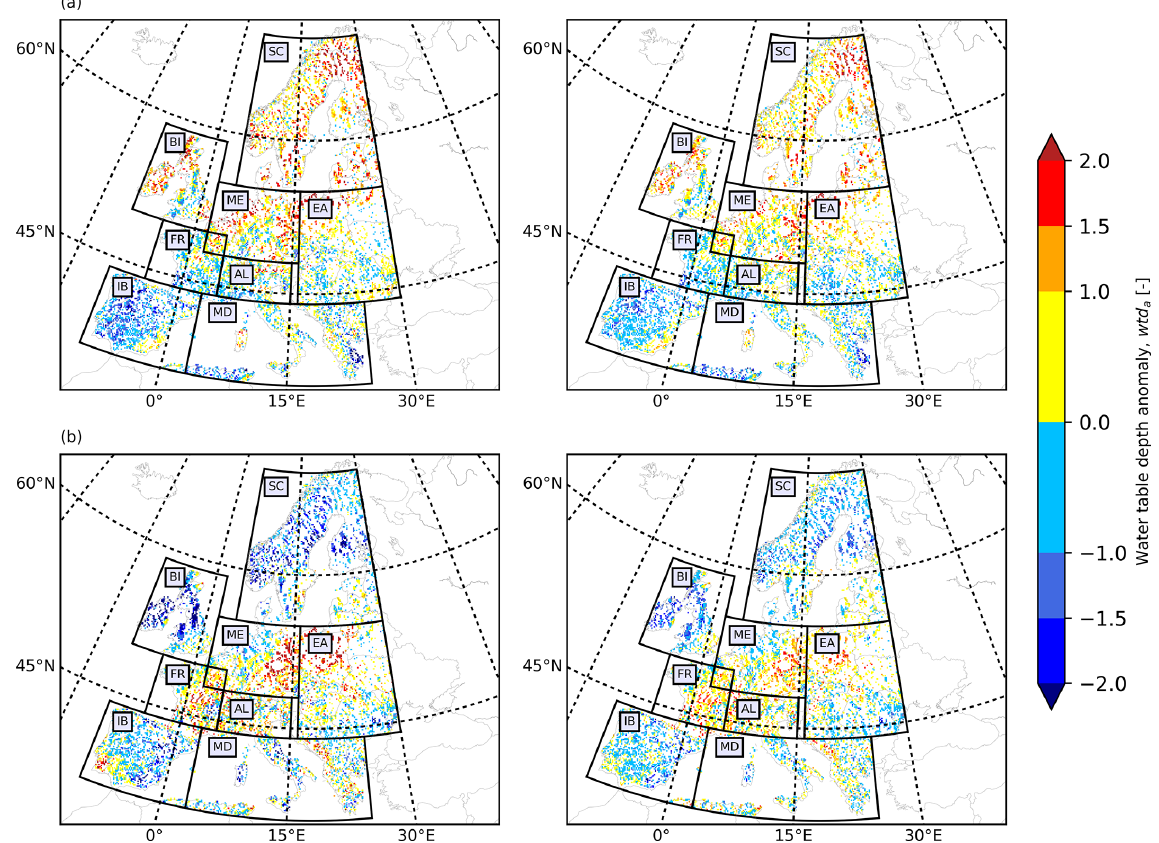
Figure B2. European wtd a maps for (a) December 2003 (i.e., in the training period) and (b) December 2015 (i.e., in the testing period) derived from the TSMP-G2A data set (left) and the results from LSTM networks